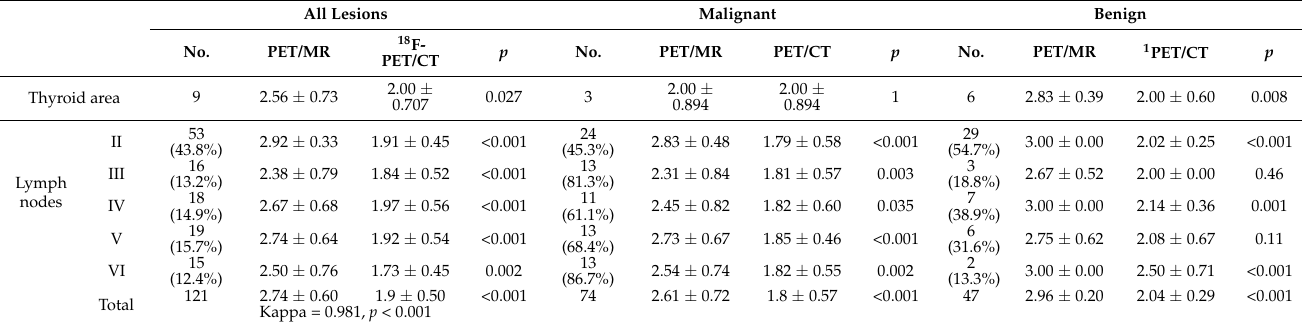
Table 4. Conspicuity score of recurrent or metastatic lesions in relation to location (scoring criteria referring to [26]). All Lesions